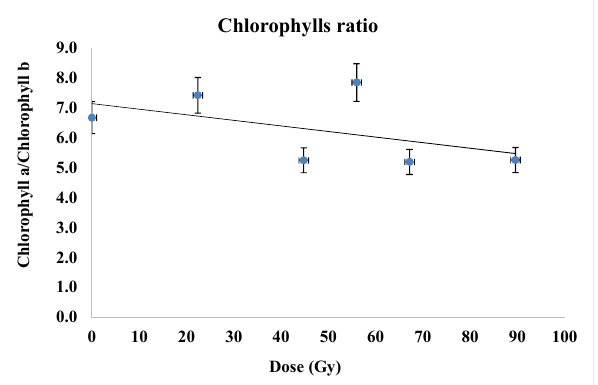
Figure 9. The influence of proton beam at the Bragg peak on the ratio of chlorophylls . Three assay repetitions were conducted for each experimental variant .